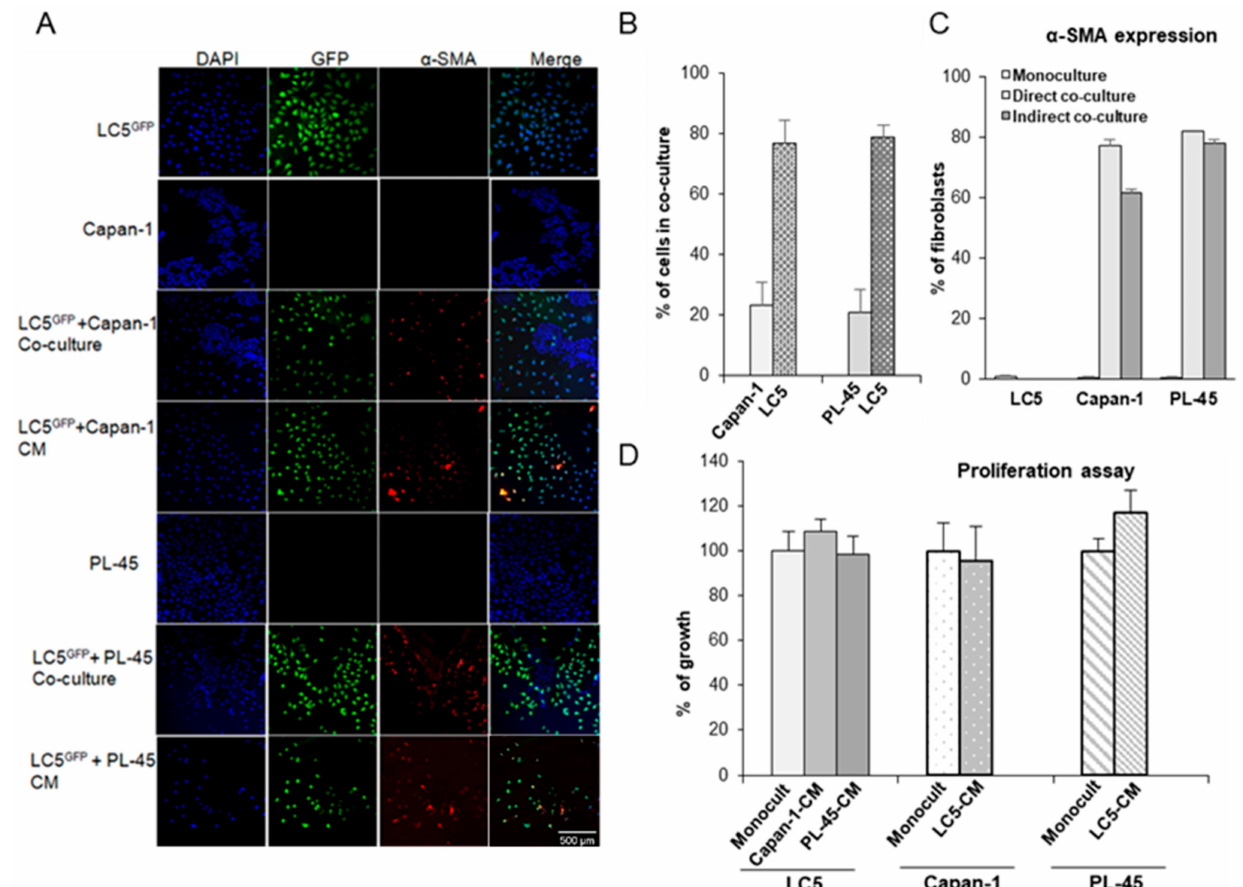
Figure 2. Coculture modifies the expression of activation markers in tumor cells and fibroblasts without affecting prolifer- ation. Activated fibroblast LC5-GFP + express α -SMA in direct and indirect cocultures with pancreatic tumor cells lines. Rows 1, 2, and 5: indicated cells in monoculture; rows 3 and 4: LC5 GFP in direct or indirect coculture, respectively, with Capan-1 pancreatic tumor cell line; rows 6 and 7: LC5 GFP in direct and indirect coculture with PL-45 pancreatic tumor cell line ( A ). Representative bar graph showing percentage of fibroblast and tumor cells in direct cocultures is shown. Data were obtained by counting cells in three different fields of three different photographs ( B ). Representative bar graph showing percentage of fibroblasts expressing α -SMA in direct or indirect cocultures with respect to monoculture is shown. Data were obtained from three independent experiments and are reported as mean ± SD ( C ). Proliferation assays of cells growing in conditioned medium from fibroblasts or tumor cells are shown with respect to cells growing as monocultures. Data are presented as the mean ± SD of three independent experiments ( D ). LC5 GFP : LC5 fibroblasts expressing GFP protein. CM: Conditioned medium. The green color indicated GFP-transfected fibroblasts, the red color indicates α -SMA, and the blue color indicated the